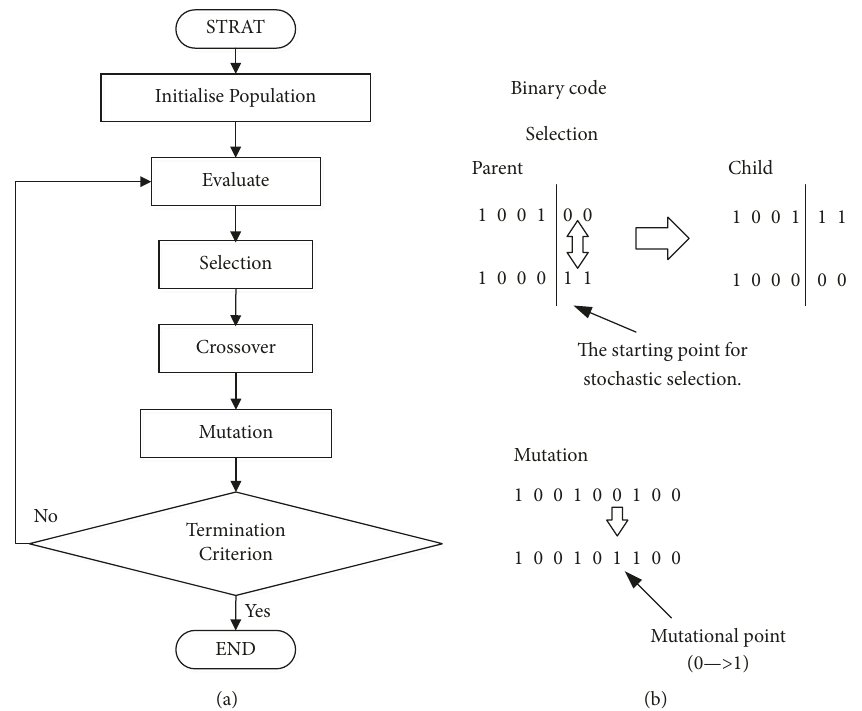
Figure 3: (a) Optimization flowchart of genetic algorithm. (b) Process diagram of selection and